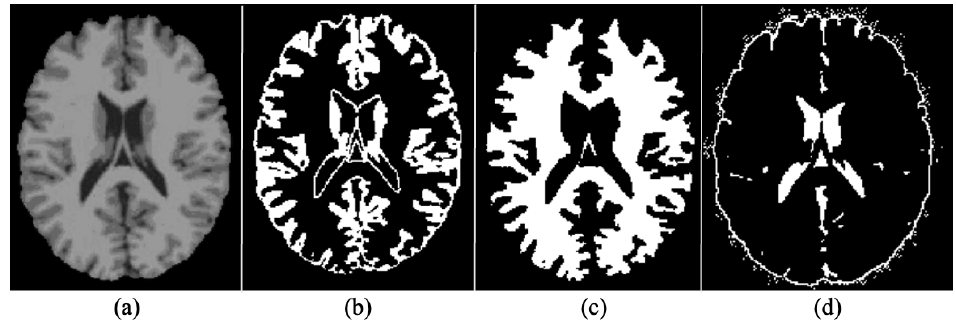
Figure 6. ( a ) Original ( b ) Grey Matter (GM ( c ) White Matter (WM) ( d ) Cerebrospinal